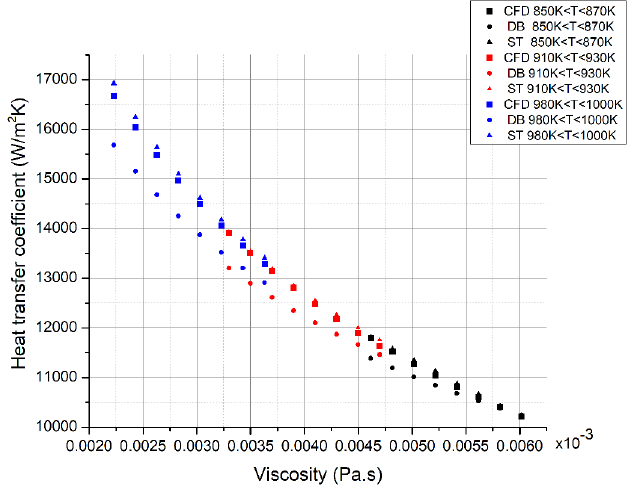
Fig. 10. Heat transfer coefficient versus thermal conductivity values obtained from the sensitivity analysis. Comparisons with Dittus Boelter and Sieder Tate